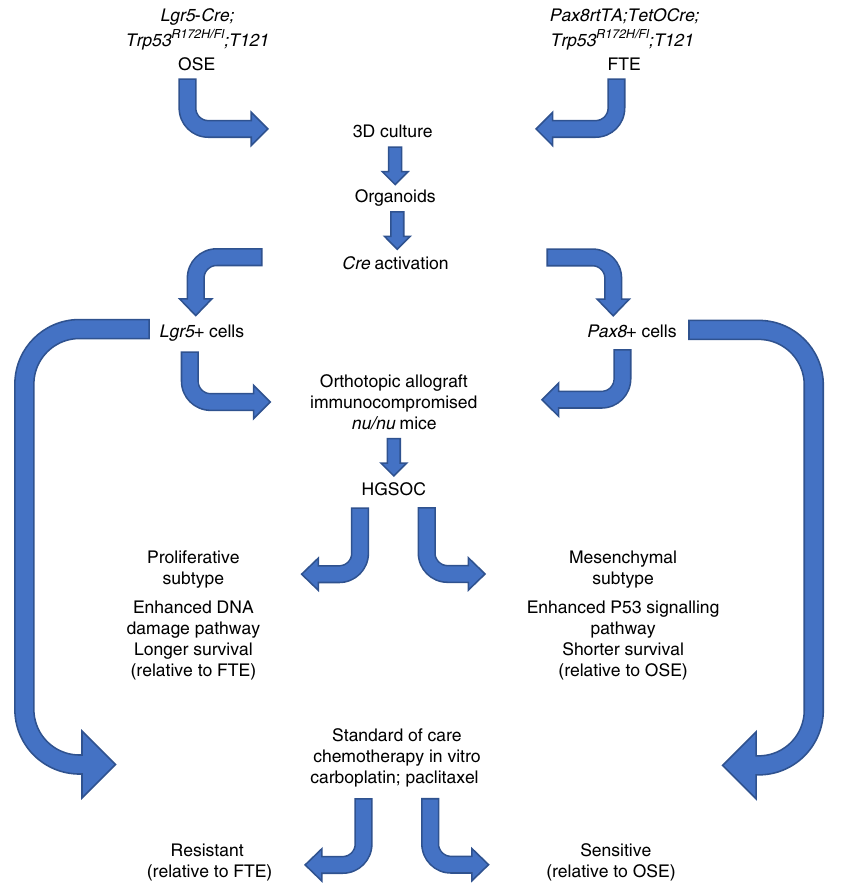
Fig. 1 The same genetic lesions targeted to OSE and FTE organoids result in different HGSOC-subtype in mice and different sensitivities to standard of care chemotherapy in